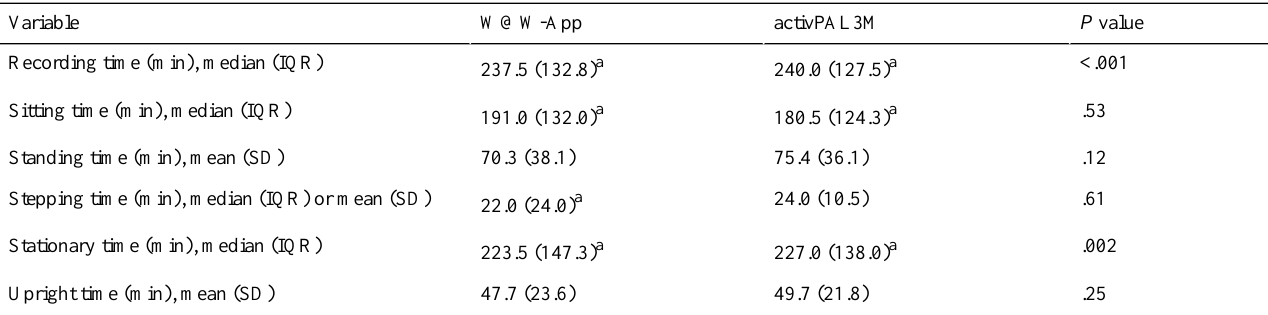
Table 1. Descriptive characteristics and statistical significance ( P value) of the differences between the W@W-App+MetaWearC and the activPAL3M for minutes spent in different activity behaviors (N=20).